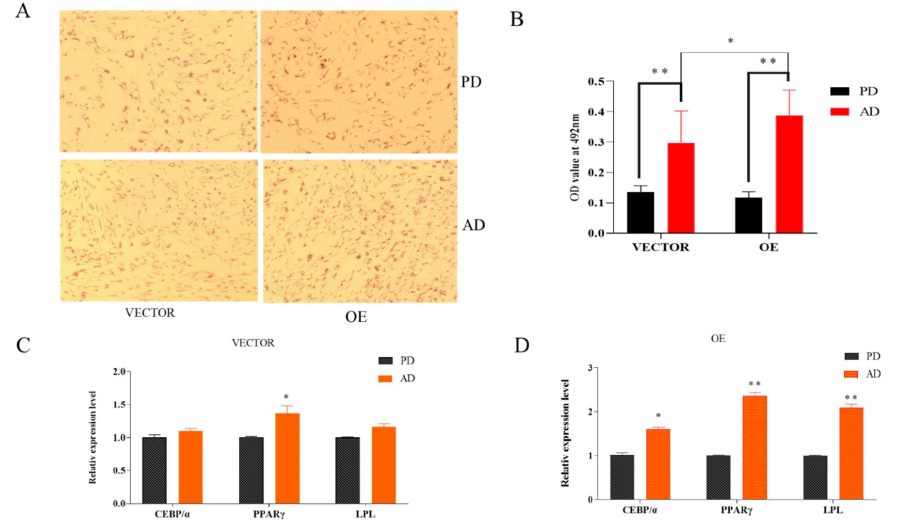
Figure 3. Adipocytes differentiated for 2 days. ( A ) Oil red staining, pre-differentiation (PD), after differentiation (AD). ( B ) OD value of preadipocytes and adipocytes, relative expression of ACADL . ( C , D ) Expression level of marker genes. “*” significant difference and “**” very significant difference.